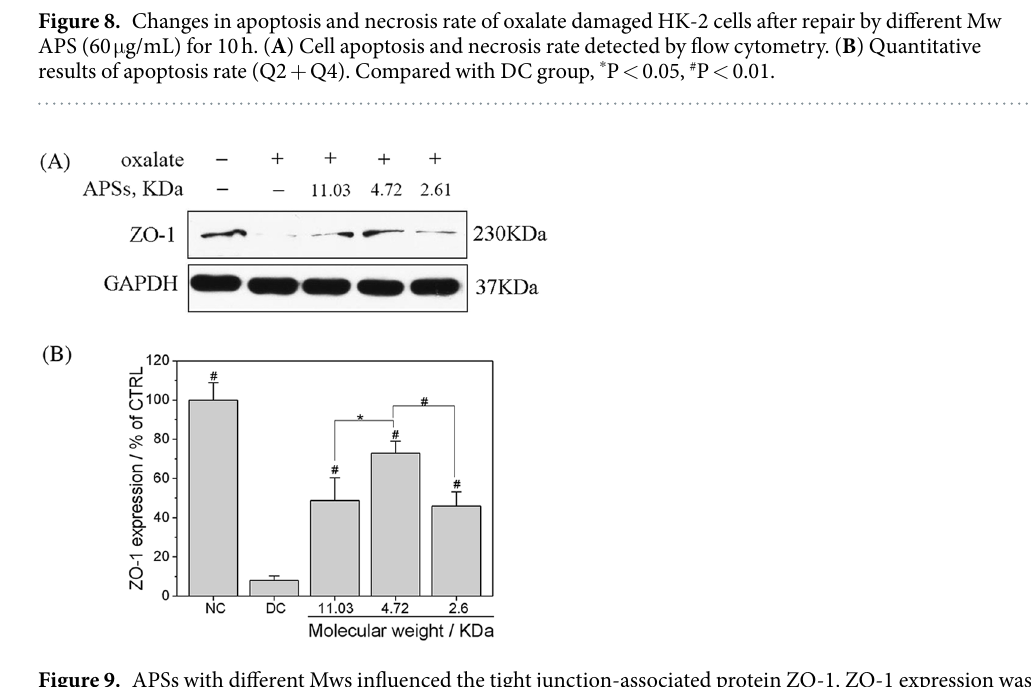
Figure 9. APSs with different Mws influenced the tight junction-associated protein ZO-1. ZO-1 expression was detected by Western blot analysis ( A ) and was quantified by Imagel software ( B ). Compared with DC group, * P < 0.05; # P <